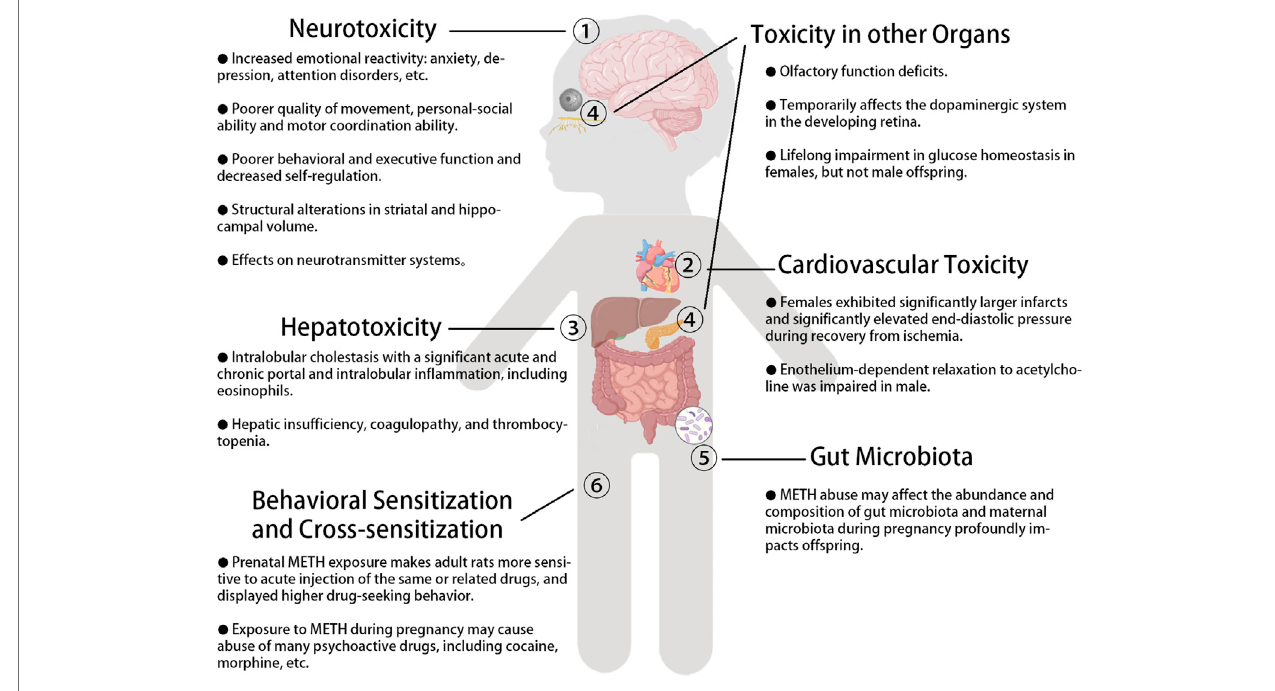
FIGURE 1 | The adverse effects of prenatal METH exposure on the